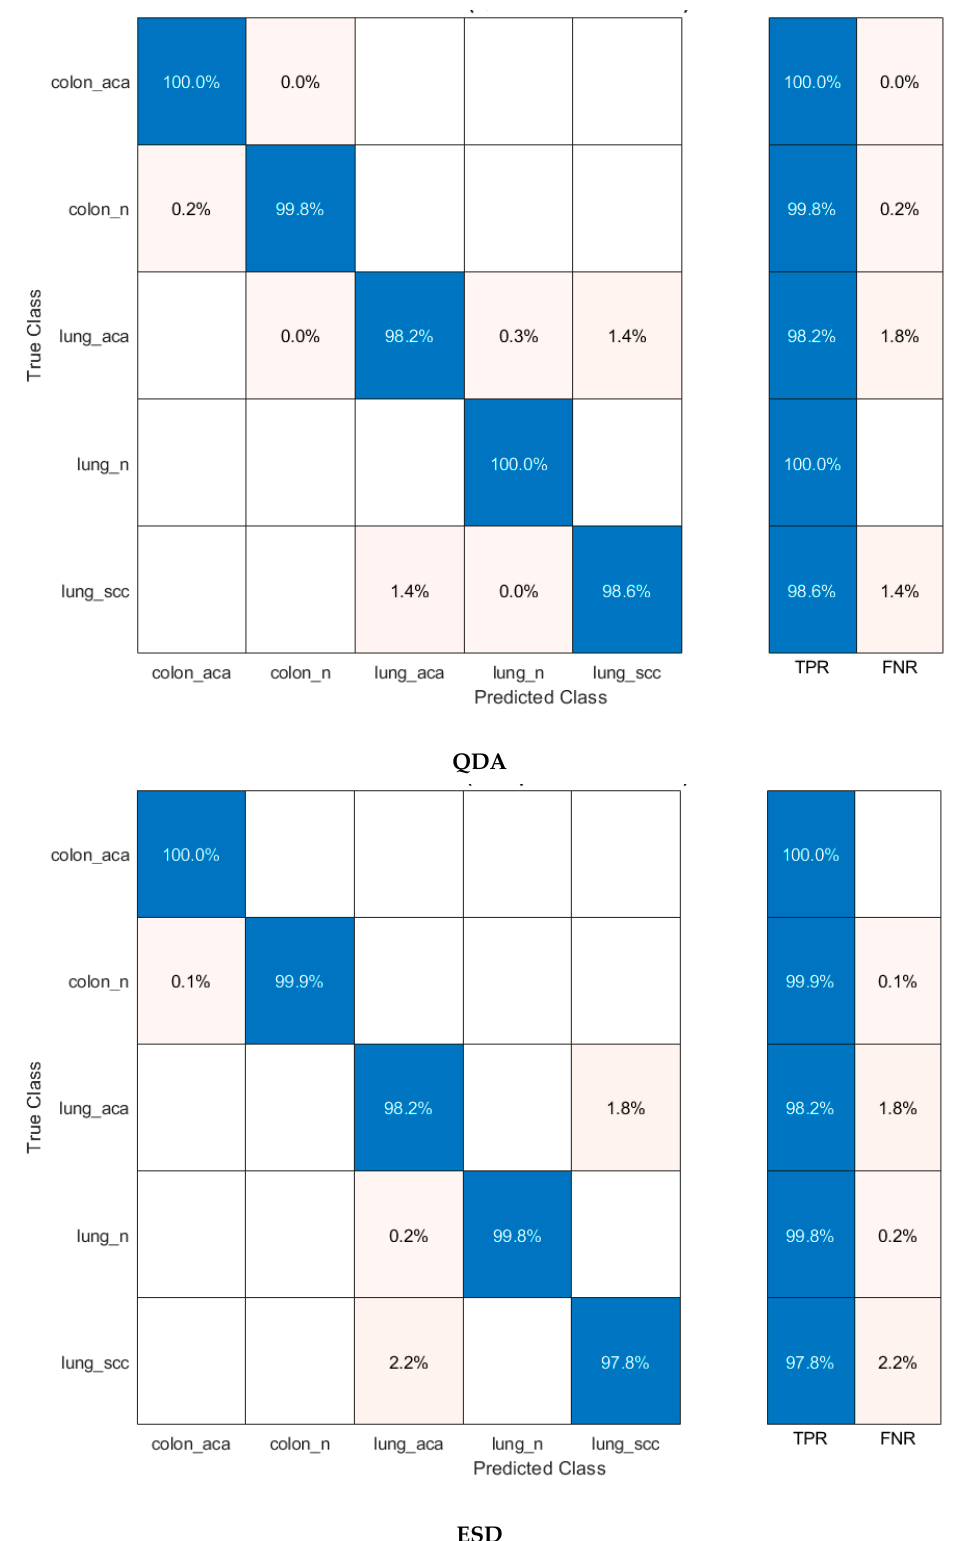
Figure 9. Confusion matrices obtained as a result of the classification of FHWT-based incorporated CNN features using DWT with machine learning algorithms.